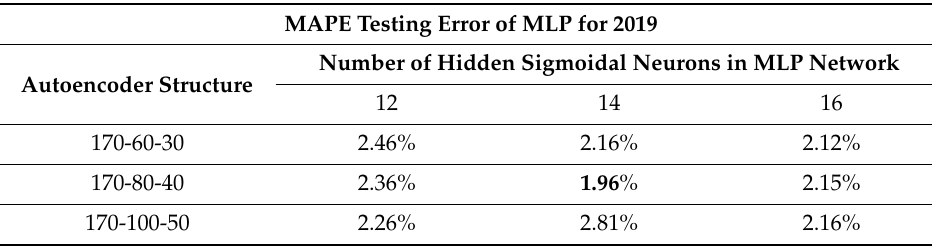
Table 2. Mean MAPE errors for all the weeks of 2019, using MLP network as a predictor. MAPE Testing Error of MLP for